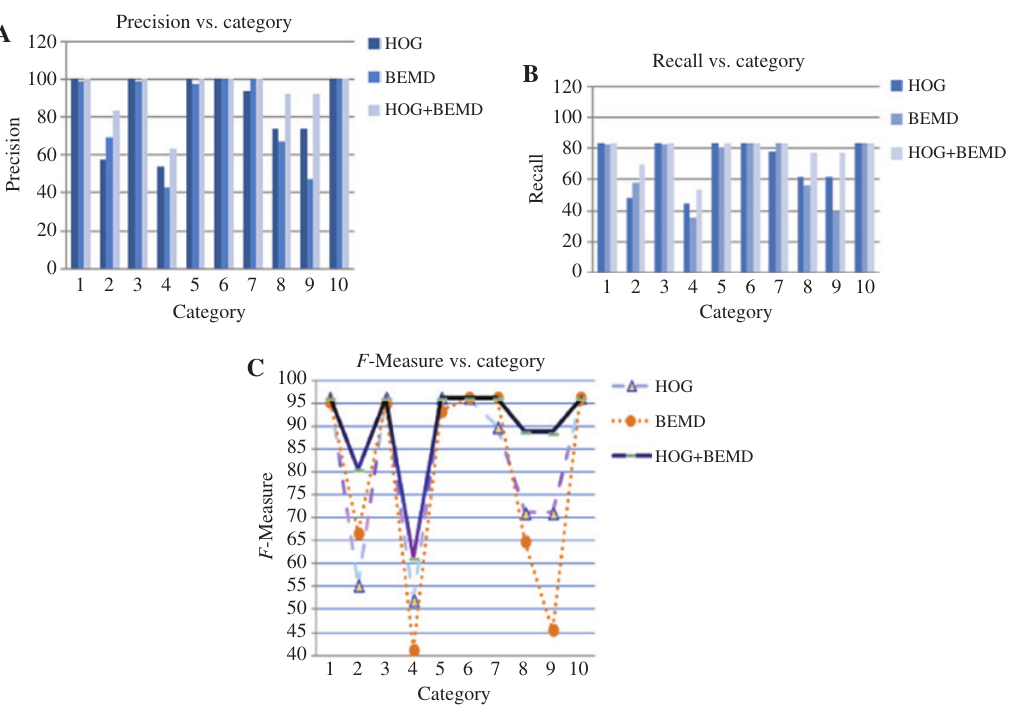
Figure 7: Precision, Recall, and F -measure Graphs. (A) Graph showing the precision value of the various techniques employed. (B) Graph showing the recall value of the